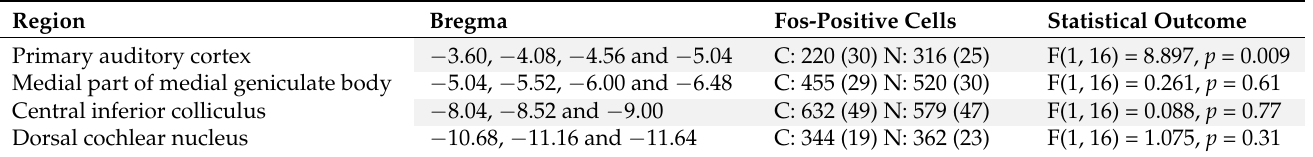
Table 2. C-Fos results of the measured regions in noise-exposed group (N) vs. control (C) group. Bregma